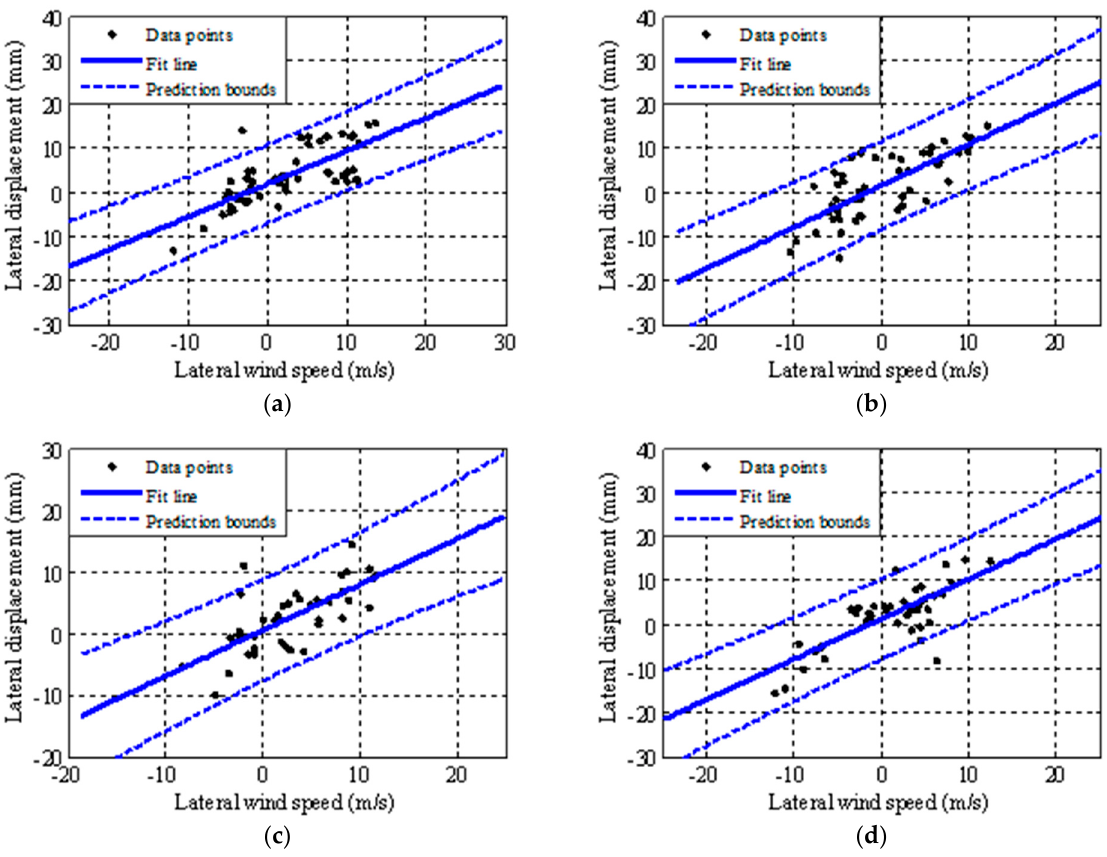
Figure 10. Linear regression model of lateral wind speed and displacement in the mid-span of the bridge after fusion from Cases 1–4. ( a ) Case 1. ( b ) Case 2. ( c ) Case 3. ( d ) Case 4.